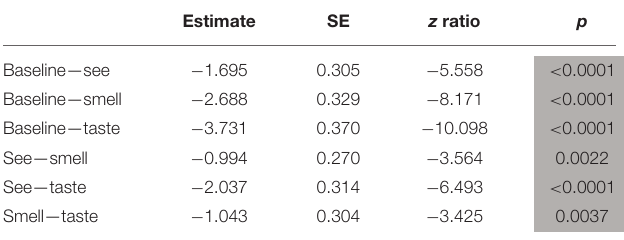
TABLE 4 | Pairwise comparisons for Experiment